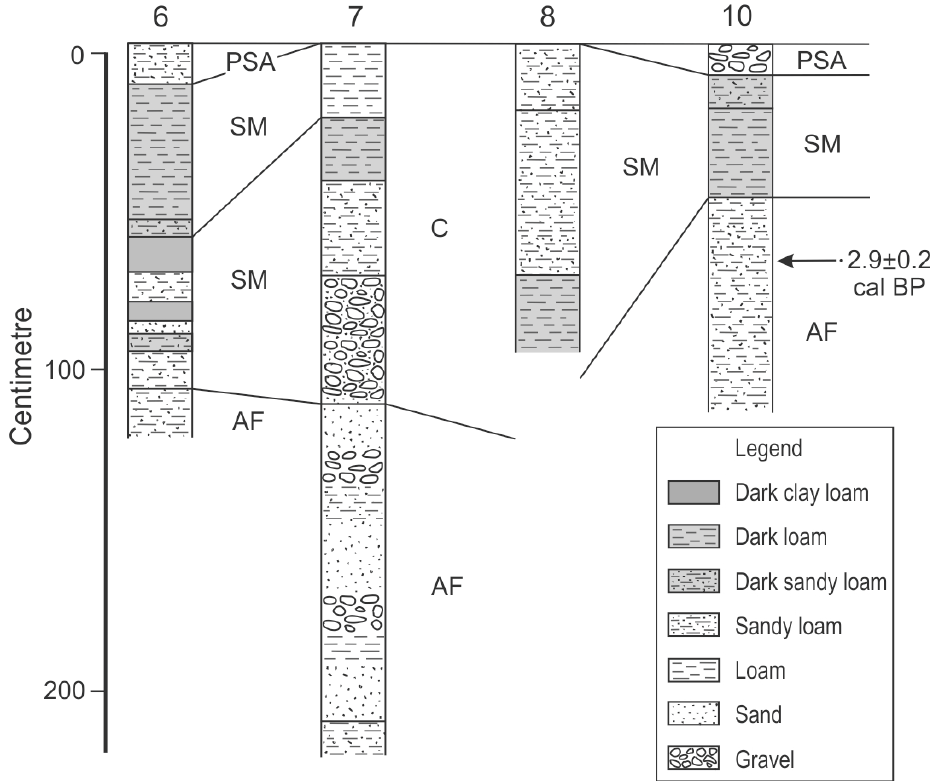
Figure 5. Stratigraphic sections 6 – 10 of Takalarup Creek. PSA = Post Settlement Alluvium, AF = Alluvial Fill, SM = Swampy Meadow, C = Colluvium.